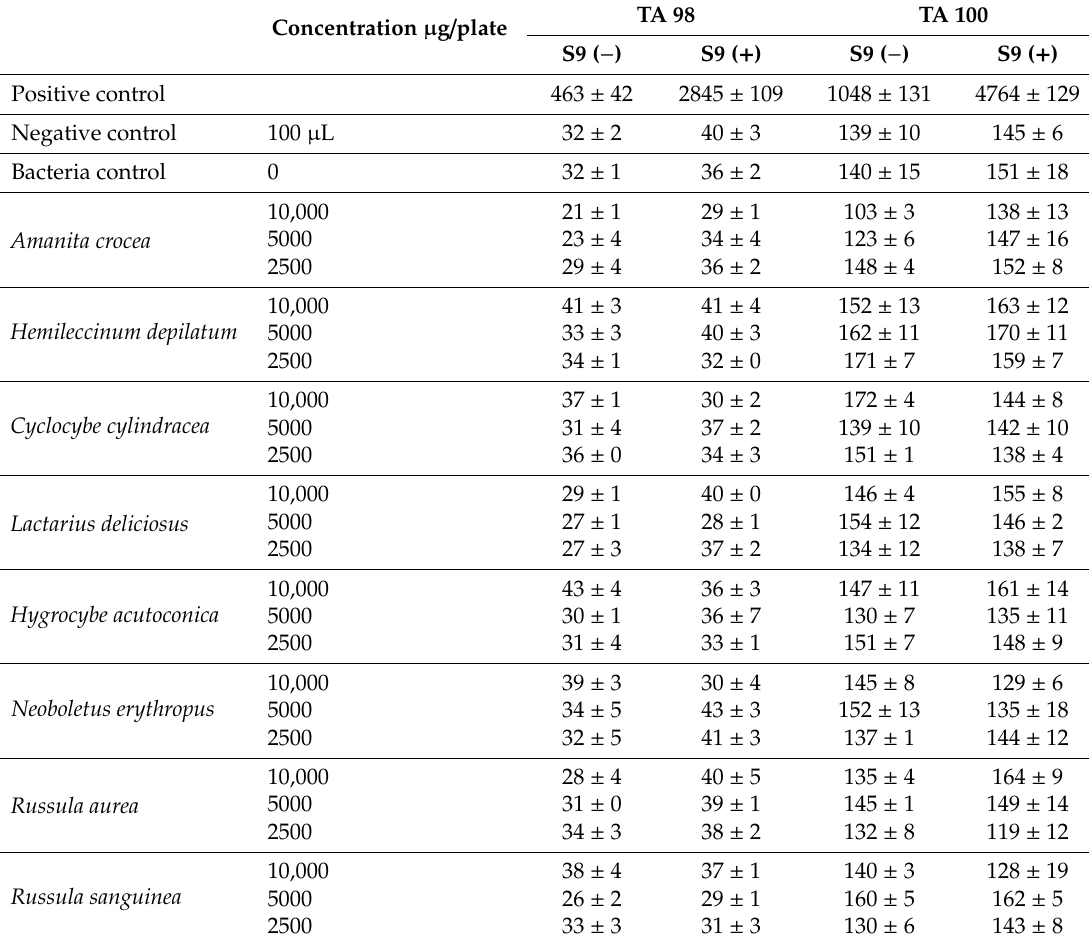
Table 5. Mutagenic properties of the tested